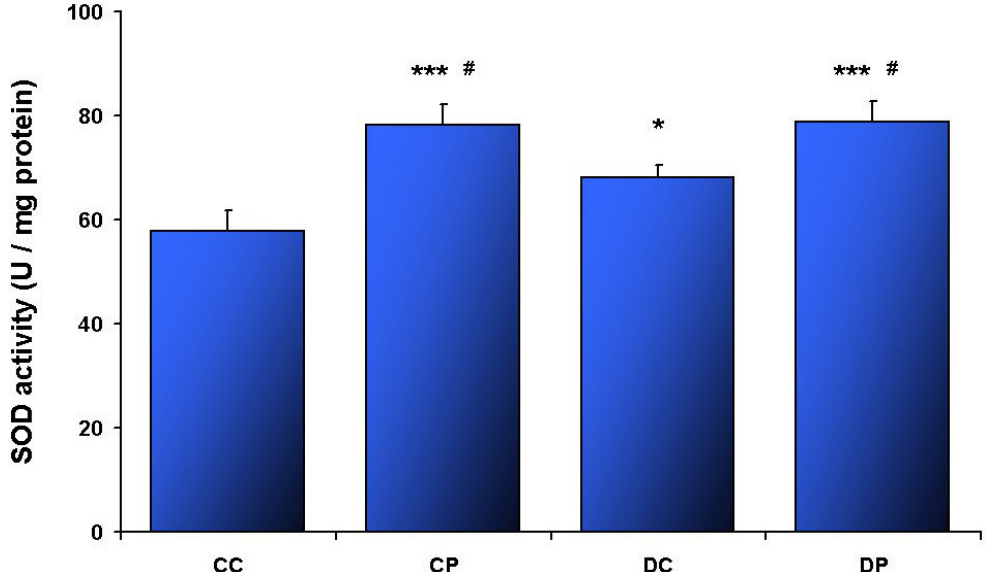
Figure 2. Superoxide dismutase activity in SOL muscle; control diet (CC), control diet and EtP (CP), HFD (DC), HFD and EtP (DP). Values are means ± SE. * p < 0.05 as compared